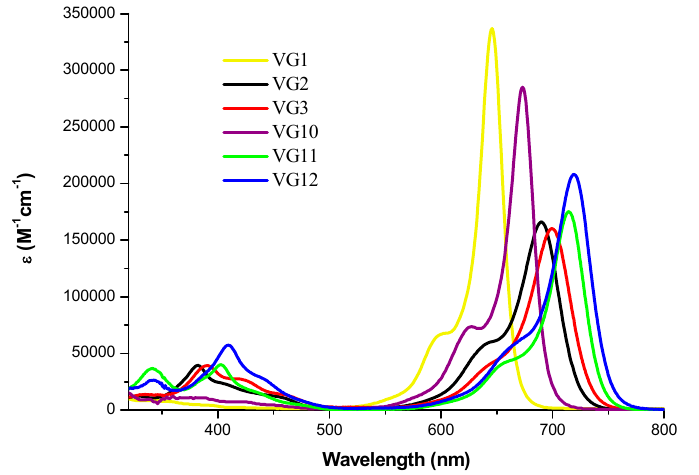
Figure 3. Absorption spectra of VG1 ‐ C8, VG2 ‐ C8, VG3 ‐ C8, VG10 ‐ C8, VG11 ‐ C8 and VG12 ‐ C8 in ethanol. Extending the π -conjugation by replacing the indolenine with a benzoindolenine (VG1 Ñ